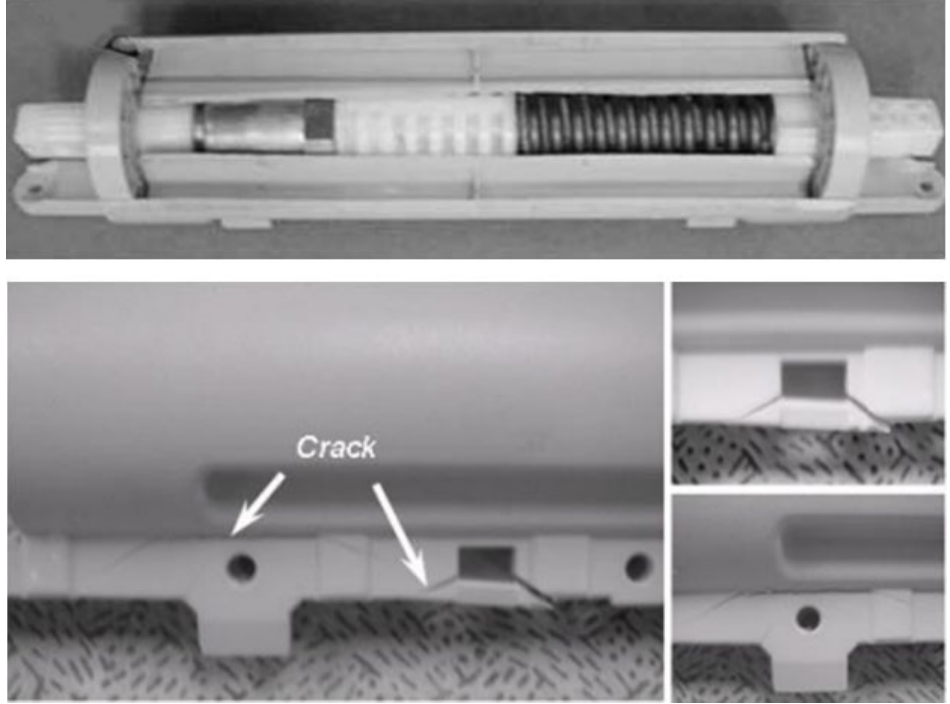
Figure 6. Damaged HKS in field after use.